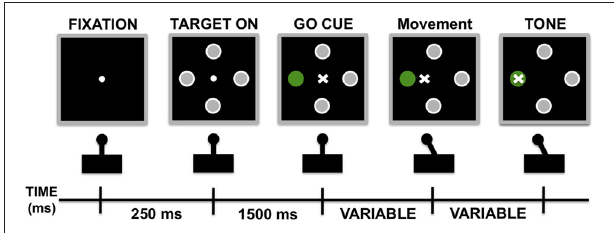
FIGURE 2 | Schematic representation of behavioral